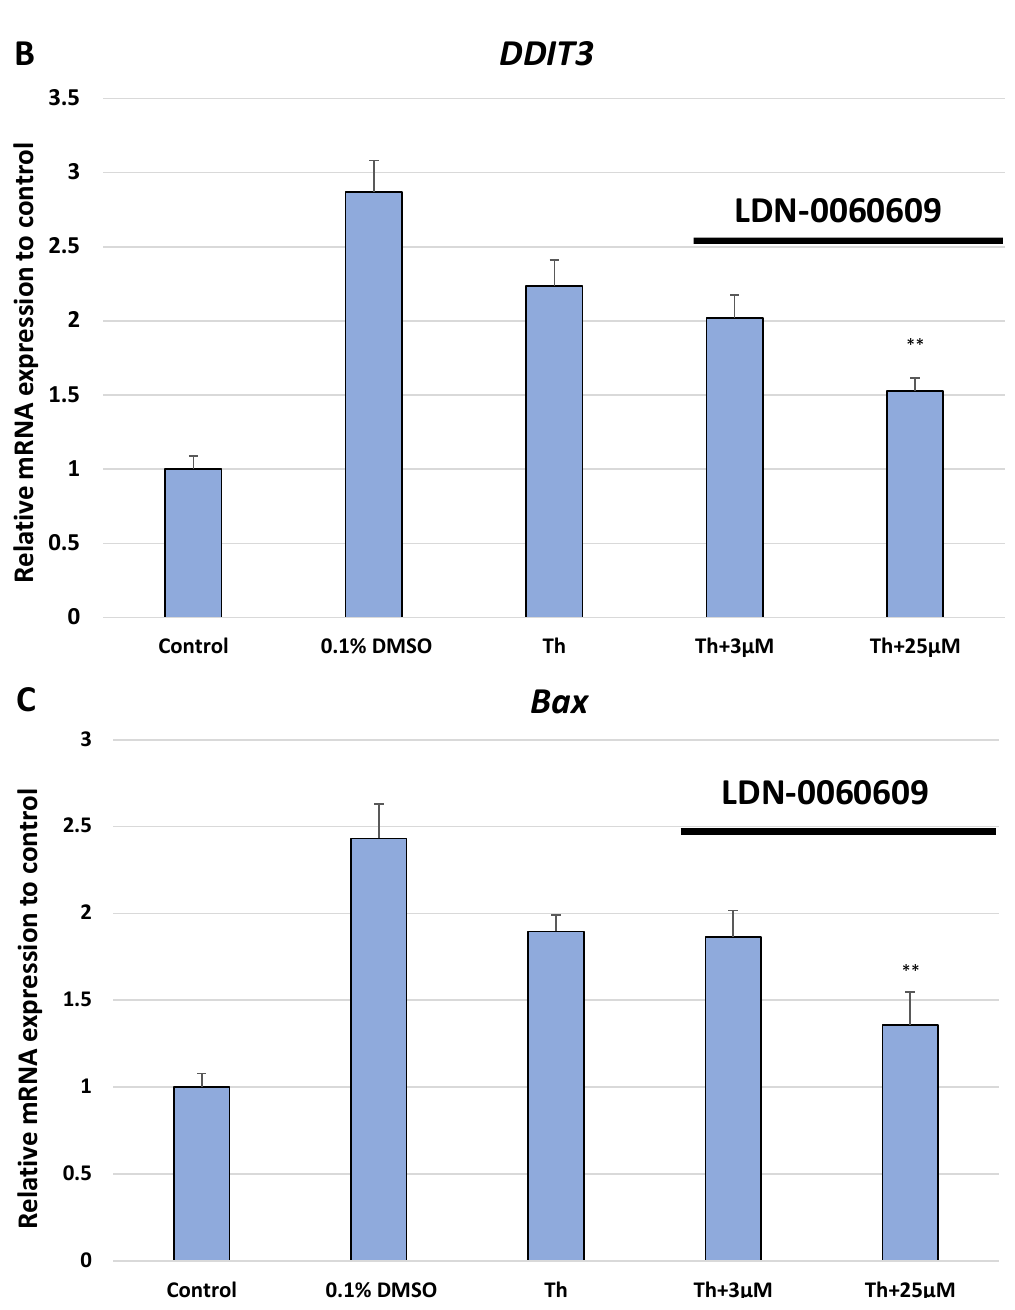
Figure 2. Analysis of the expression profile of the ER stress marker genes: ATF4 ( A ), DDIT3 ( B ) and Bax ( C ) in HTM cells with Th-induced ER stress conditions or treated with both Th and PERK inhibitor LDN-0060609. Analysis was performed using the TaqMan gene expression assay. Each of the statistical analyses in the individual experiments was based on the results of three independent tests. Data are expressed as mean ± SE ( n = 3). On the graphs, the differences were statistically significant as follows: ** p < 0.01, *** p < 0.001 versus Th. Control—untreated HTM cells; DMSO—dimethyl sulfoxide;